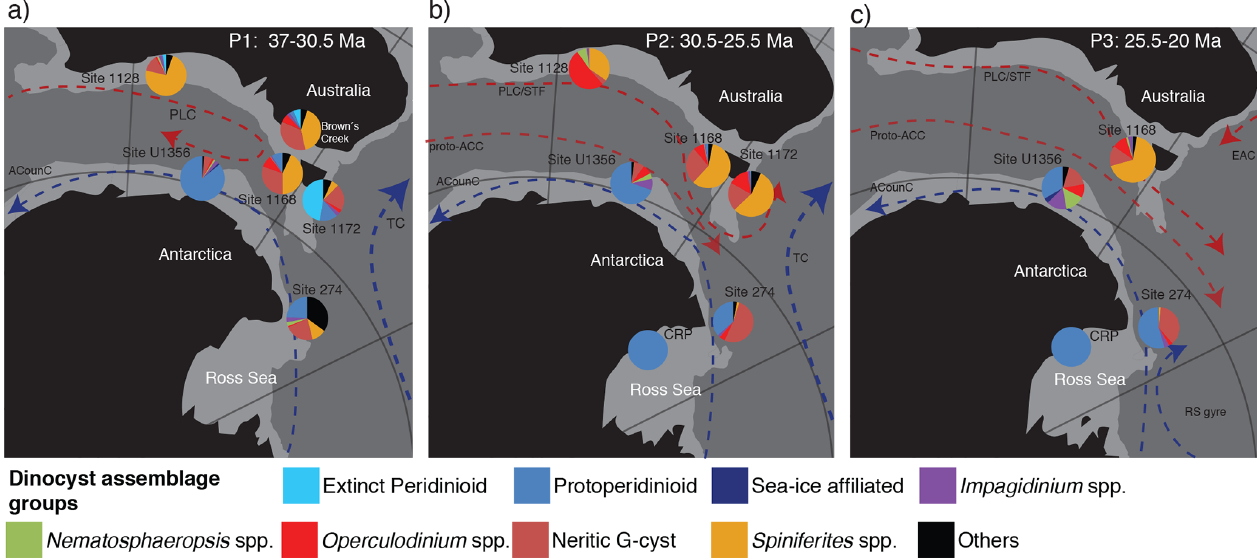
Figure 6. Dinocyst biogeographic patterns in the Tasmanian sector in three time slices in the late Eocene–early Miocene: (a) 37–30.5Ma (31 data points), (b) 30.5–25Ma (42 data points) and (c) 25–20Ma (50 data points). The dinocyst assemblage of ODP Site 1168 (this study) is presented along with that from IODP Site U1356 (Bijl et al., 2018), DSDP Site 274 (Hoem et al., 2021a), Cape Roberts Project (CRP) (Clowes et al., 2016), ODP Site 1172 (Sluijs et al., 2003), Site 1128 and Browns Creek (Houben et al., 2019) (Table S3 in the Supplement). The dinocyst taxa and/or ecological groups are indicated by different colours (see legend), following interpretations by Röhl et al. (2004) and Frieling and Sluijs. (2018). The “extinct peridinioid” group consists of Phthanoperidinium spp., Spinidinium spp. and Vozzhennikovia spp., Deflandrea phosphoritica and the Wetzelielloideae group. The blue and red stippled lines with arrows indicate flow direction, with proposed cool (blue) and warm (red) ocean currents that may have prevailed in the indicated areas during the different time intervals (e.g. Stickley et al., 2004a). EAC is the East Australian Current, PLC is the proto-Leeuwin Current, STF is the subtropical front, TC is the Tasman Current, proto-ACC is the proto-Antarctic Circumpolar Current and ACountC is the Antarctic Counter Current. The palaeogeographic position of the sites is generated with GPlates (http://www.gplates.org, last access: 13 June 2016), based on the global plates geodynamic motion model from Müller et al. (2018). Light grey indicates the continental